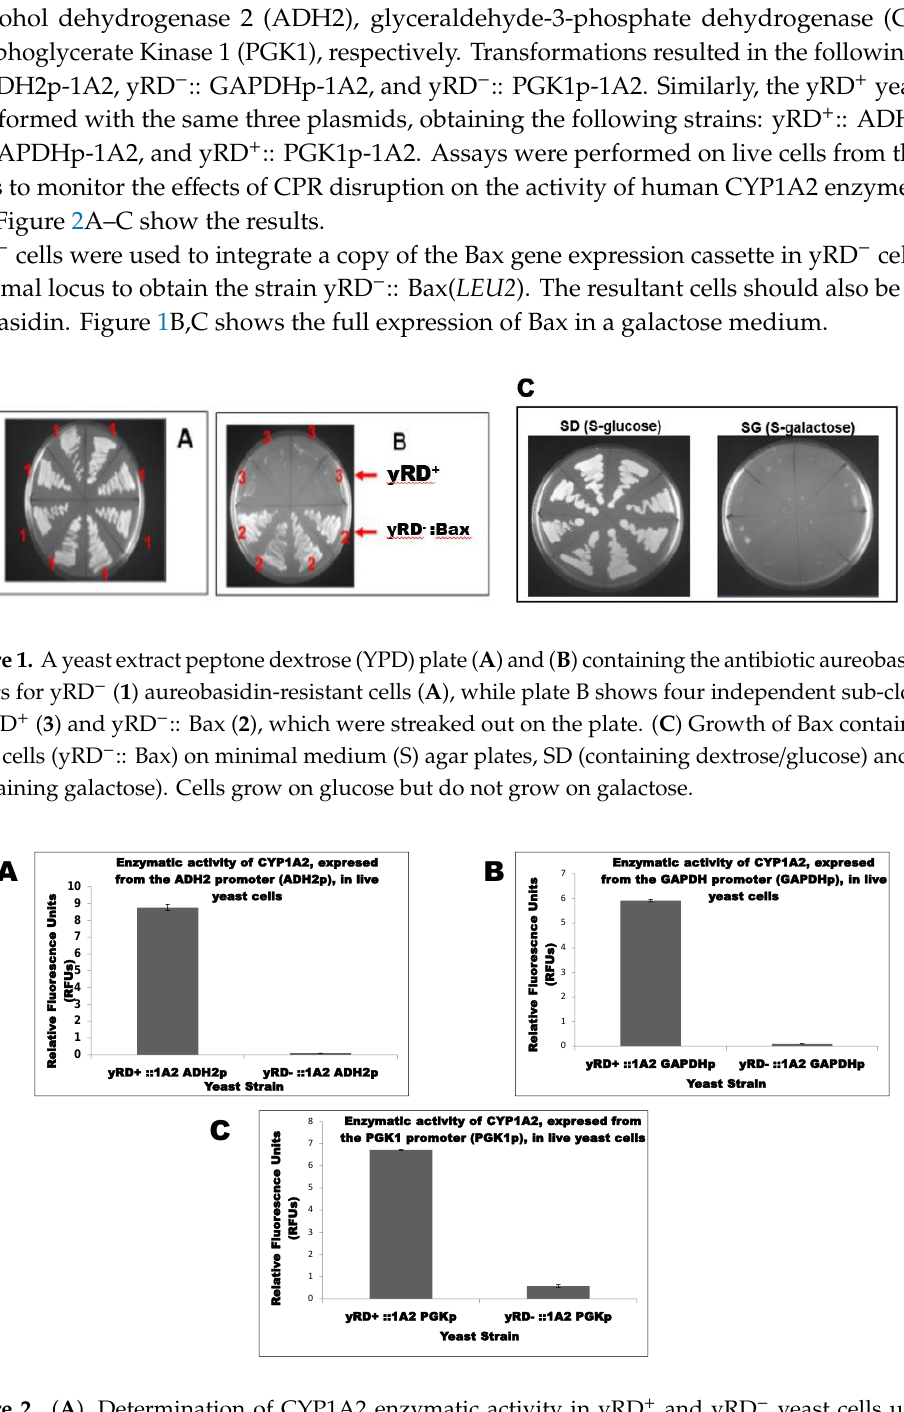
Figure 2. ( A ). Determination of CYP1A2 enzymatic activity in yRD + and yRD − yeast cells using 3-cyano-7-ethoxycoumarin (CEC) as a substrate. CYP1A2 gene expression is driven by the ADH2 promoter (ADH2p). The results show that the CPR (in this case, the yeast reductase, yRD) is essential for CYP450 activity. ( B ) Determination of CYP1A2 enzymatic activity in yRD + :: GAPDH-1A2 and yRD − :: GAPDH-1A2 yeast cells using 3-cyano-7-ethoxycoumarin (CEC) as a substrate. CYP1A2 gene expression is driven by the GAPDH promoter (GAPDHp). The results show that a CPR (i.e., yRD) is essential for CYP450 activity. ( C ). Determination of CYP1A2 enzymatic activity in yRD + :: PGK1-1A2 and yRD − :: PGK1-1A2 yeast cells using 3-cyano-7-ethoxycoumarin (CEC) as a substrate. CYP1A2 gene expression is driven by the PGK1 promoter (PGK1p). The results show that a CPR (i.e., yRD) is essential for CYP450